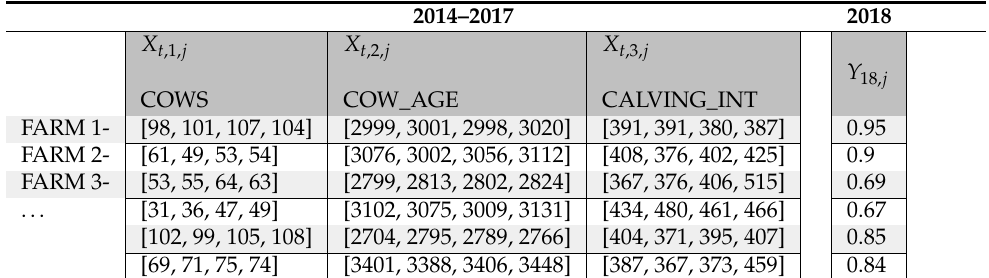
Table 4. Vectorial panel dataset configuration for 2014–2018. On the left side, the input vectorial variables X t , j , i = [ X 14, j , i , X 15, j , i , X 16, j , i , X 17, j , i ] , with t ∈ { 14, . . . ,17 } , i = 1, . . . , m , and j = 1, . . . , n . On the right side, the scalar target variable Y 18